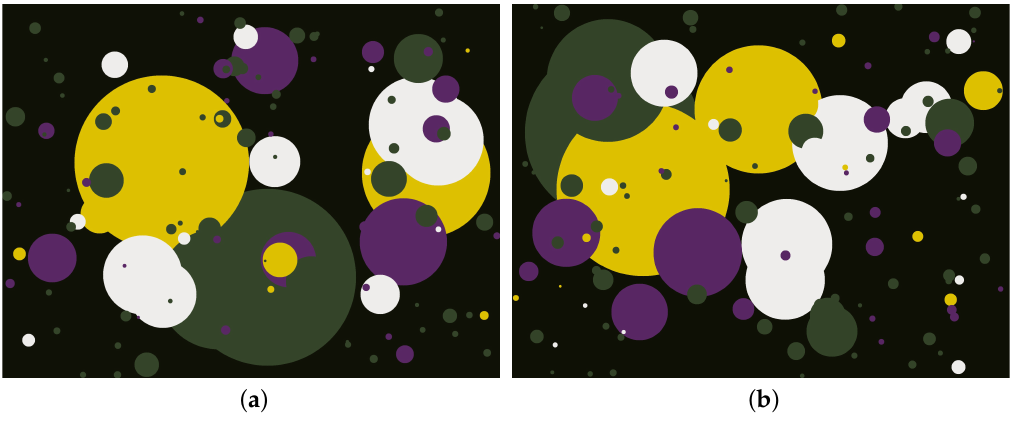
Figure 5. ( a ) Generated abstract painting; ( b ) A new abstract painting from the same original